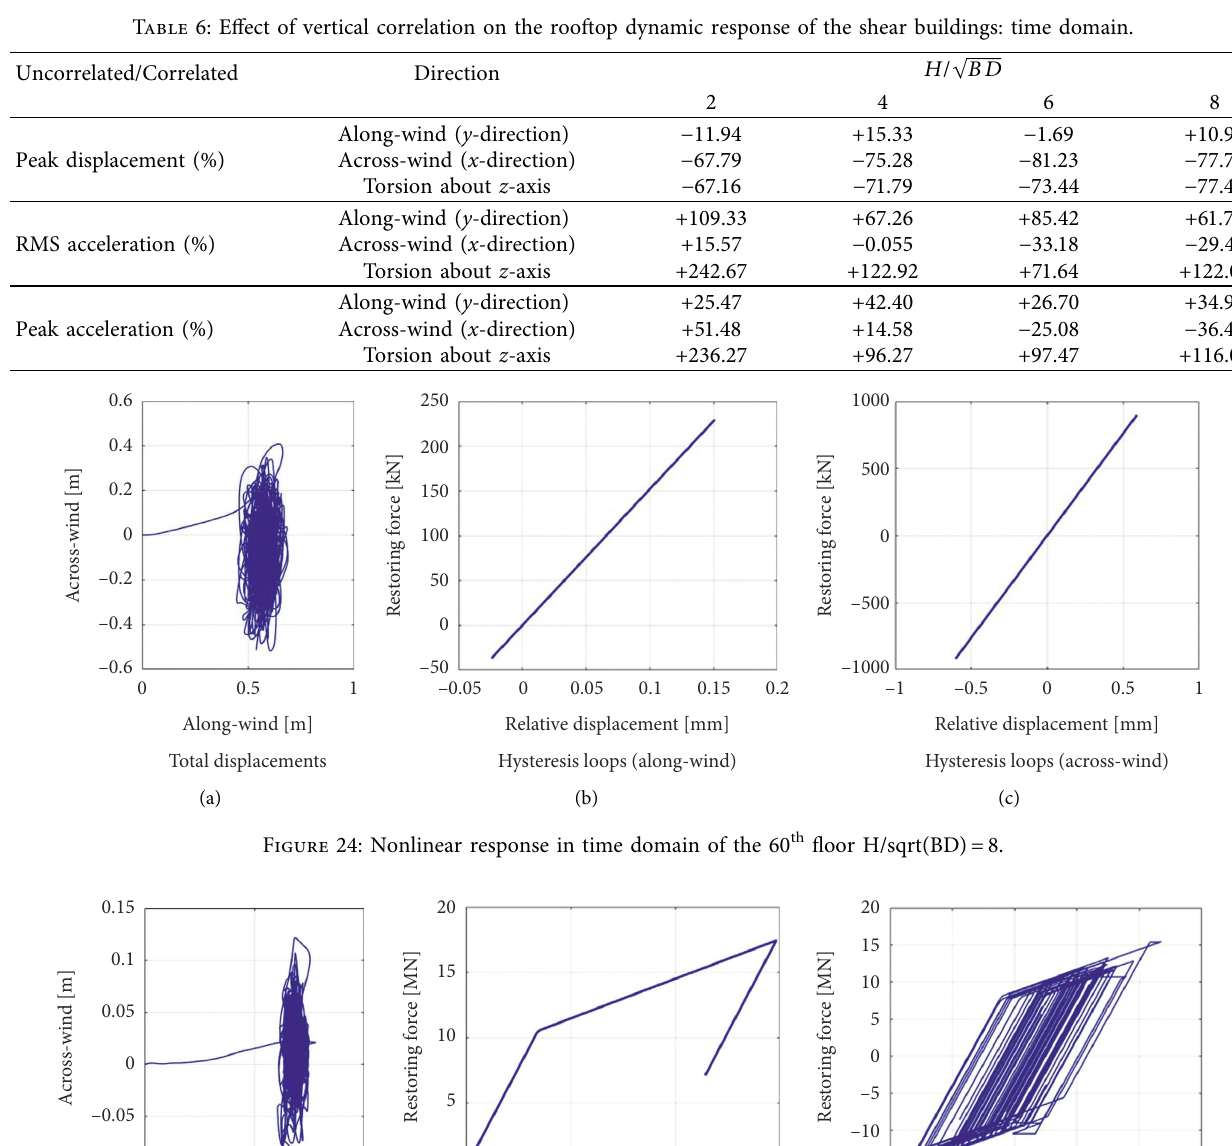
Table 6: Effect of vertical correlation on the rooftop dynamic response of the shear buildings: time domain. Uncorrelated/Correlated Direction